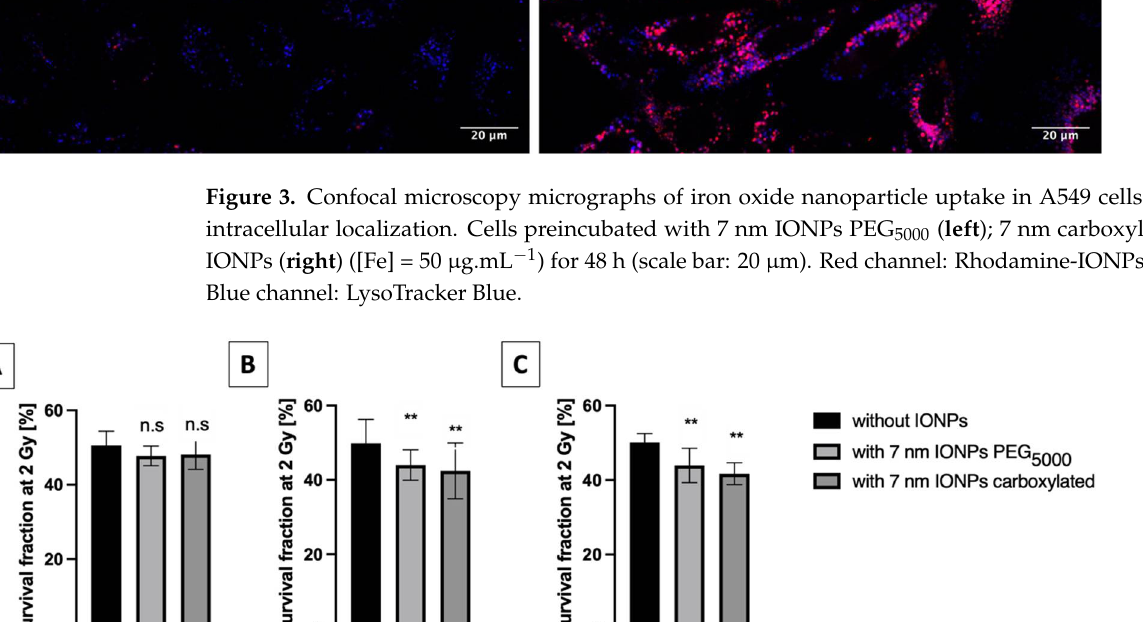
Figure 3. Confocal microscopy micrographs of iron oxide nanoparticle uptake in A549 cells and intracellular localization. Cells preincubated with 7 nm IONPs PEG 5000 ( left ); 7 nm carboxylated IONPs ( right ) ([Fe] = 50 μg.mL –1 ) for 48 h (scale bar: 20 μm). Red channel: Rhodamine-IONPs and Blue channel: LysoTracker Blue.